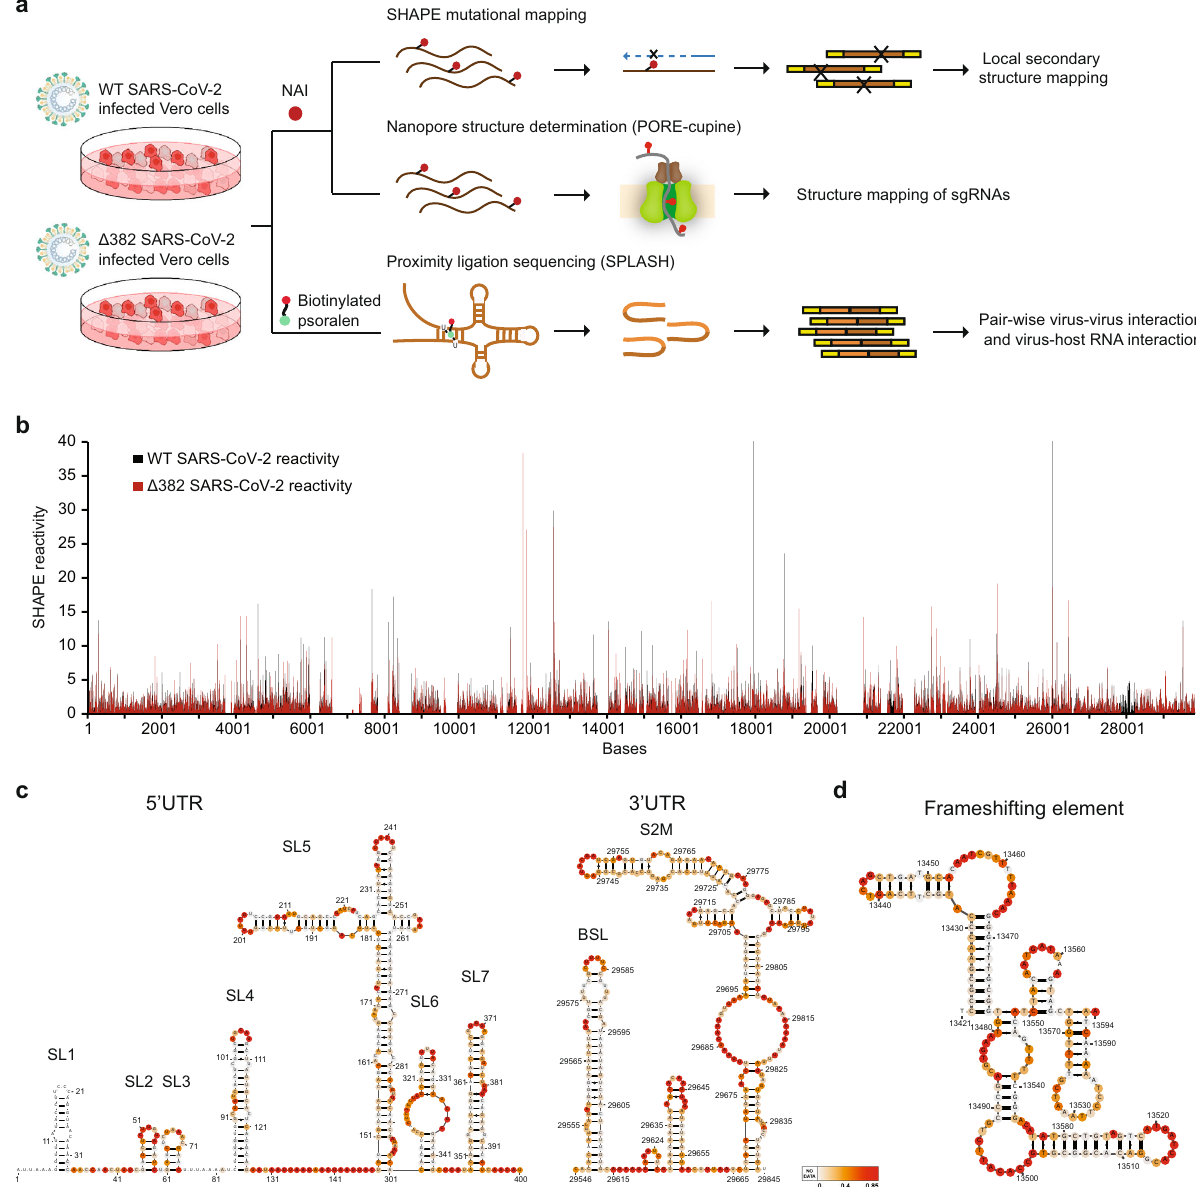
Fig. 1 Comprehensive structure and interactome mapping of SARS-CoV-2 RNA in cell. a Schematic of the different strategies that were used to probe WT and Δ 382 inside infected Vero-E6 cells. NAI was used to modify single-stranded bases in cells and these modi fi cations are then either read out directly using Nanopore direct RNA sequencing or converted into a cDNA library for Illumina sequencing. Biotinylated psoralen was used to crosslink pair-wise RNA interactions in infected cells to capture both intramolecular and intermolecular RNA-RNA interactions. b SHAPE-reactivity along with the WT (black) and Δ 382 (red) SARS-CoV-2 genome. Higher reactivity regions tend to be more single-stranded. c , d Structure models are generated using the program RNA structure using SHAPE-reactivities as constraints 54 , and visualized using VARNA 57 . The modelled structures of 5 ’ UTR and 3 ’ UTR ( c ), and that of the frameshift element ( d ) agree with known models in the literature. The frameshift element model is the highest con fi dence structure generated by RNA structure using SHAPE-MaP as constraints. Source data are provided as a Source Data fi